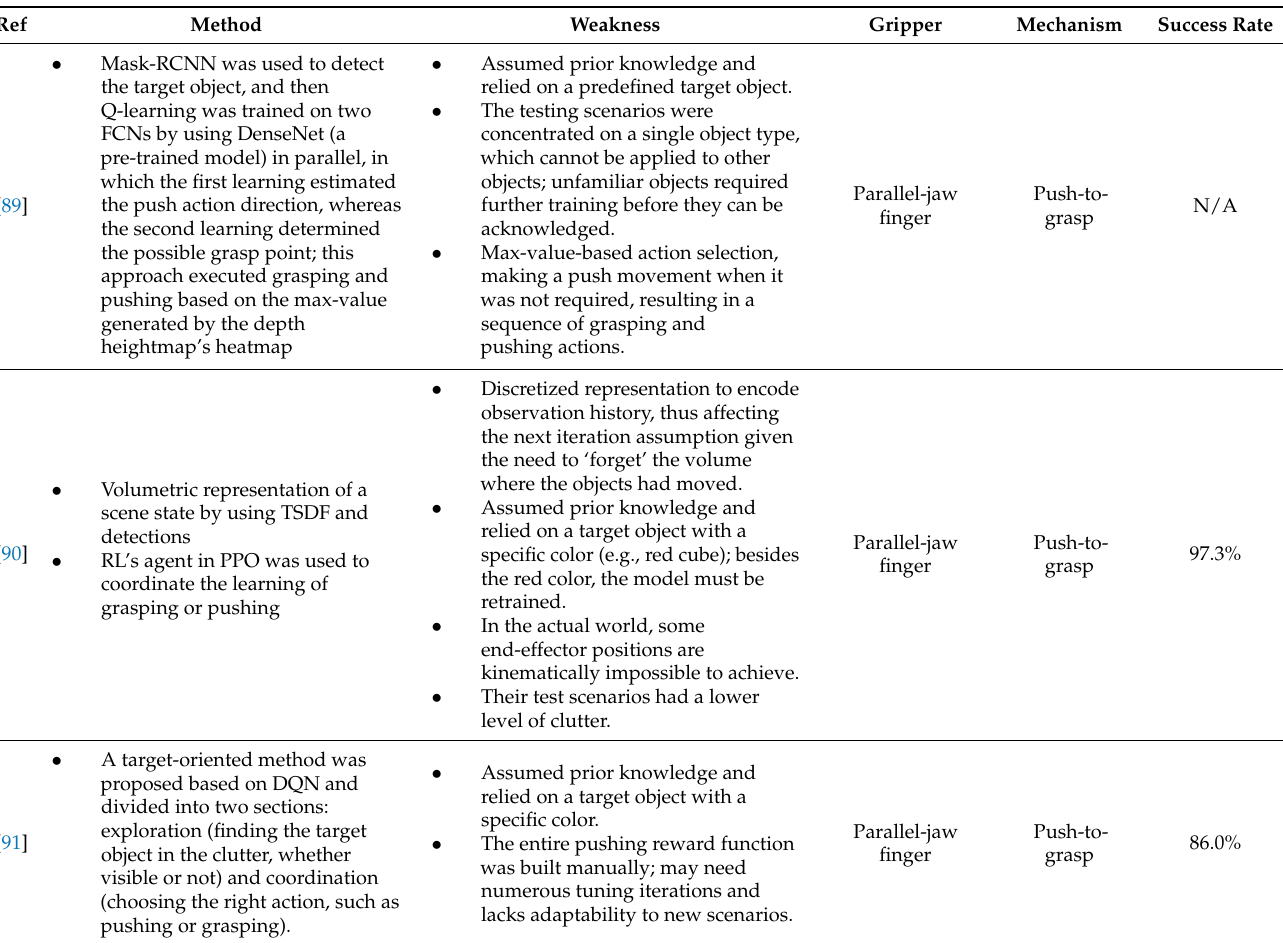
Table 4. Important articles on finding an object in a cluttered